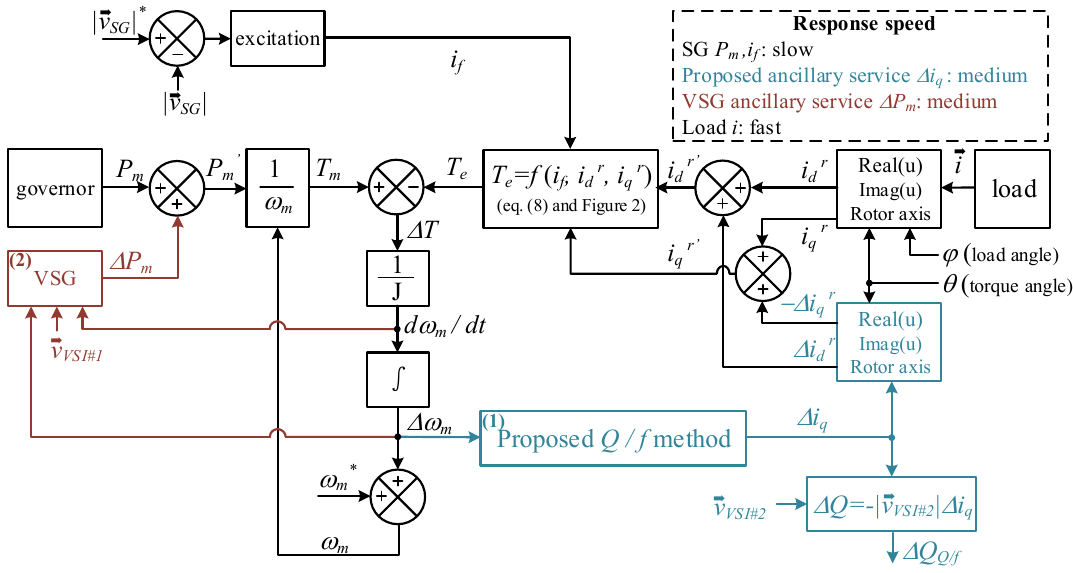
Figure 3. Frequency regulation algorithm of concerning a synchronous generator and the connected loads including both the VSG method and the proposed